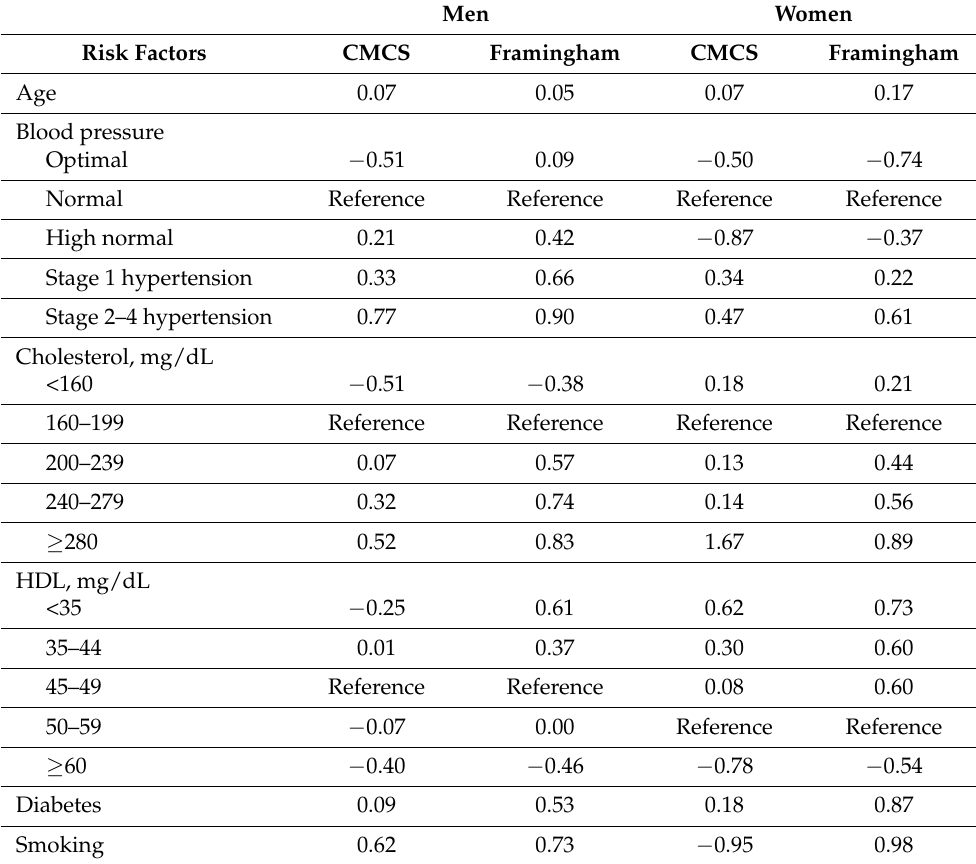
Table 3. Framingham and CMCS score coefficients. Men Women Risk Factors CMCS Framingham CMCS